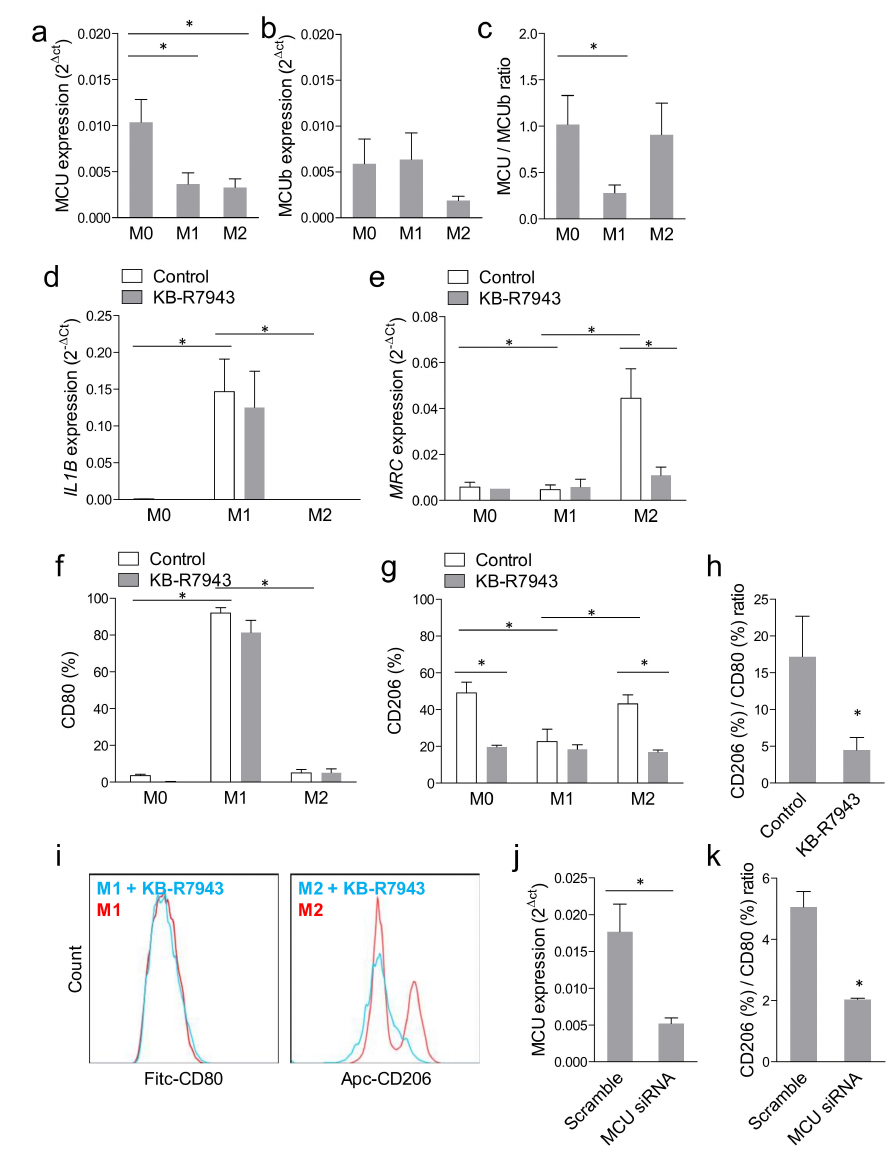
Figure 1. Mitochondrial calcium uniporter and macrophage polarization. Gene expression of MCU ( a ) and MCUb ( b ) was examined in M0 (resting), M1- and M2-polarized macrophages and the ratio between expression of MCU and MCUb ( c ) was calculated (* p < 0.05 for the indicated comparison after ANOVA). Gene expression of The M1 marker IL1B ( d ) and of the M2 marker MRC ( e ) was examined in M0, M1, and M2 macrophage with or without treatment with the MCU inhibitor KB-R7943 (* p < 0.05 for the indicated comparison after ANOVA). Surface expression of the M1 marker CD80 ( f ) and of the M2 marker CD206 ( g ) was examined by flow cytometry in M0, M1, and M2 macrophages with or without treatment with the MCU inhibitor KB-R7943 (* p < 0.05 for the indicated comparison after ANOVA). ( h ) The ratio of the surface expression of CD80 over CD206, which is considered a proxy of M1 polarization, was examined in M2-polarized cells, with or without treatment with the MCU inhibitor KB-R7943 (* p < 0.05). ( i ) Representative FACS plots of CD80 surface expression in M1 (left) and CD206 expression in M2 (right) macrophages with or without treatment with the MCU inhibitor KB-R7943. ( j ) E ffi ciency of siRNA-mediated knockdown of MCU in cells transfected with scramble siRNA or siRNA against MCU (* p < 0.05). ( k ) The ratio of the surface expression of CD206 over CD80 was examined in M2-polarized cells, with or without MCU knockdown (* p <